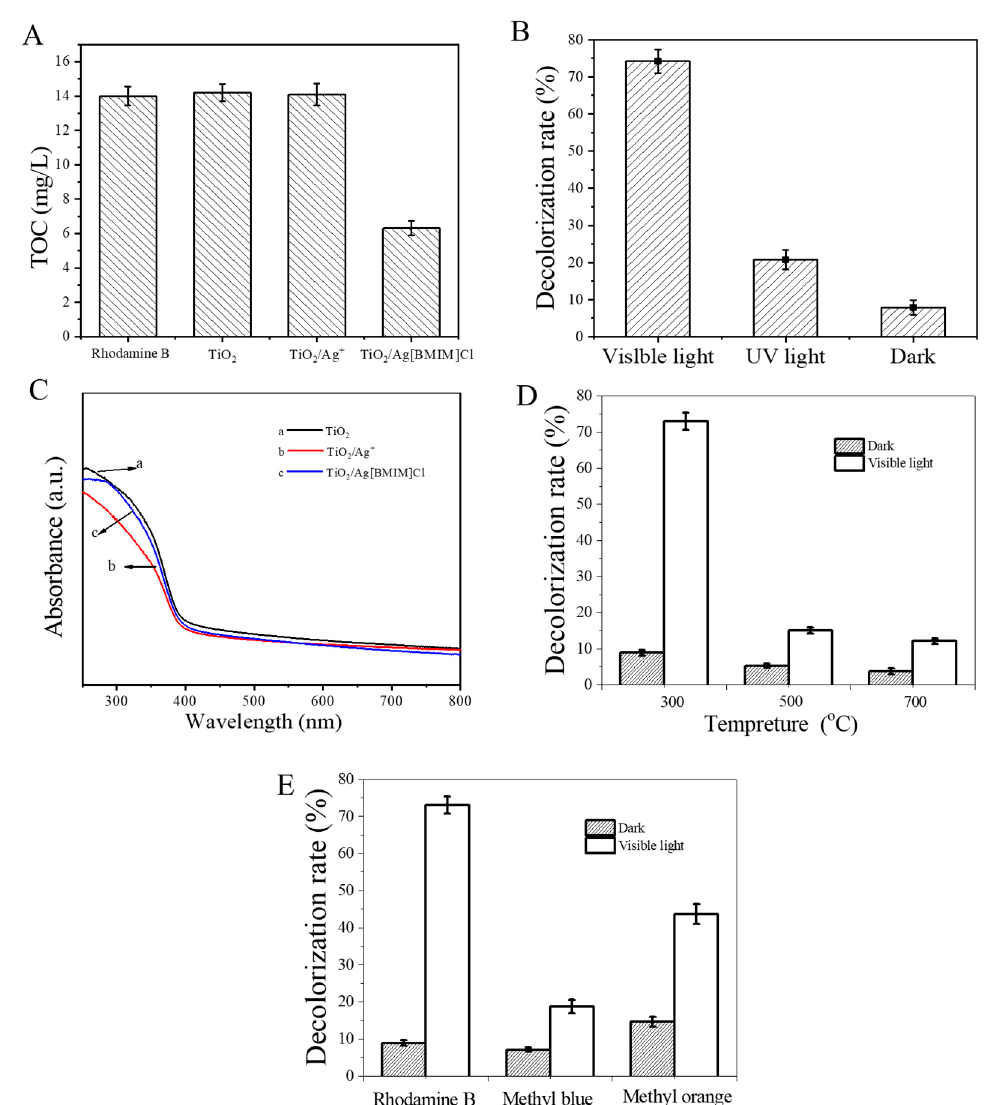
Figure 2. TOC analysis ( A ) of the TiO 2 , TiO 2 /Ag + and TiO 2 /Ag[BMIM]Cl after visible photocatalytic degradation for 2 h; decolorization rates of TiO 2 /Ag[BMIM]Cl after photocatalytic degradation for 2 h ( B ); Rh B under different irradiation sources; UV–vis DRS spectra of TiO 2 , TiO 2 /Ag + and TiO 2 /Ag[BMIM]Cl ( C ) Rh B catalyzed by TiO 2 /Ag[BMIM]Cl with different preparation temperatures of TiO 2 under visible light ( D ); different dyes under visible light ( E ) .